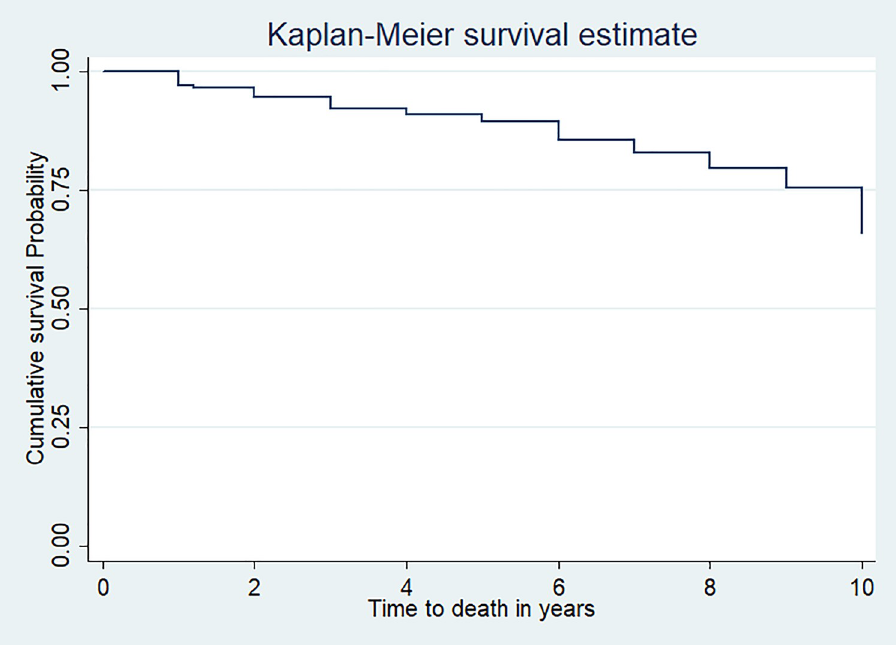
Fig 1. Kaplan Meier curve of survival proportion for TB/HIV co-infected children at public hospitals in Southern Ethiopia, 2020.